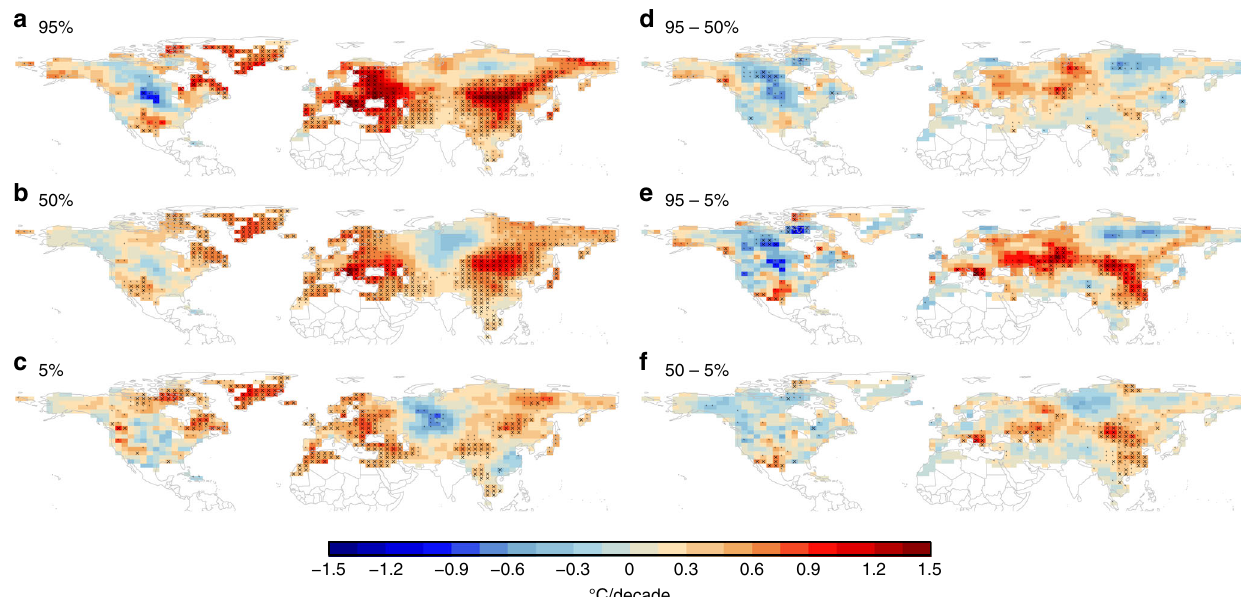
Fig. 1 Summer trends in surface temperature over 1980 – 2011. a 95th, b 50th, and c 5th quantile of the HadGHCND 133 gridded daily dataset; differences in the trends of different quantiles, plotted in d – f , re fl ect changes in the width of the distribution. Over most mid-latitude regions, especially over Eurasia, the width of the distribution has broadened and thus variability has increased. (Figure created using R statistical software)